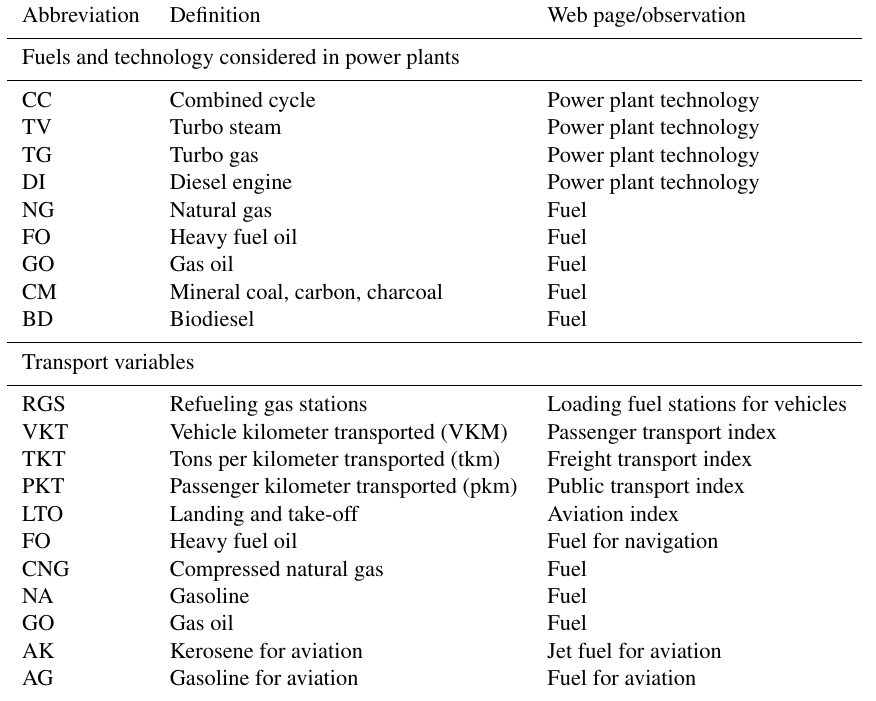
Table A2. Other abbreviations used in this